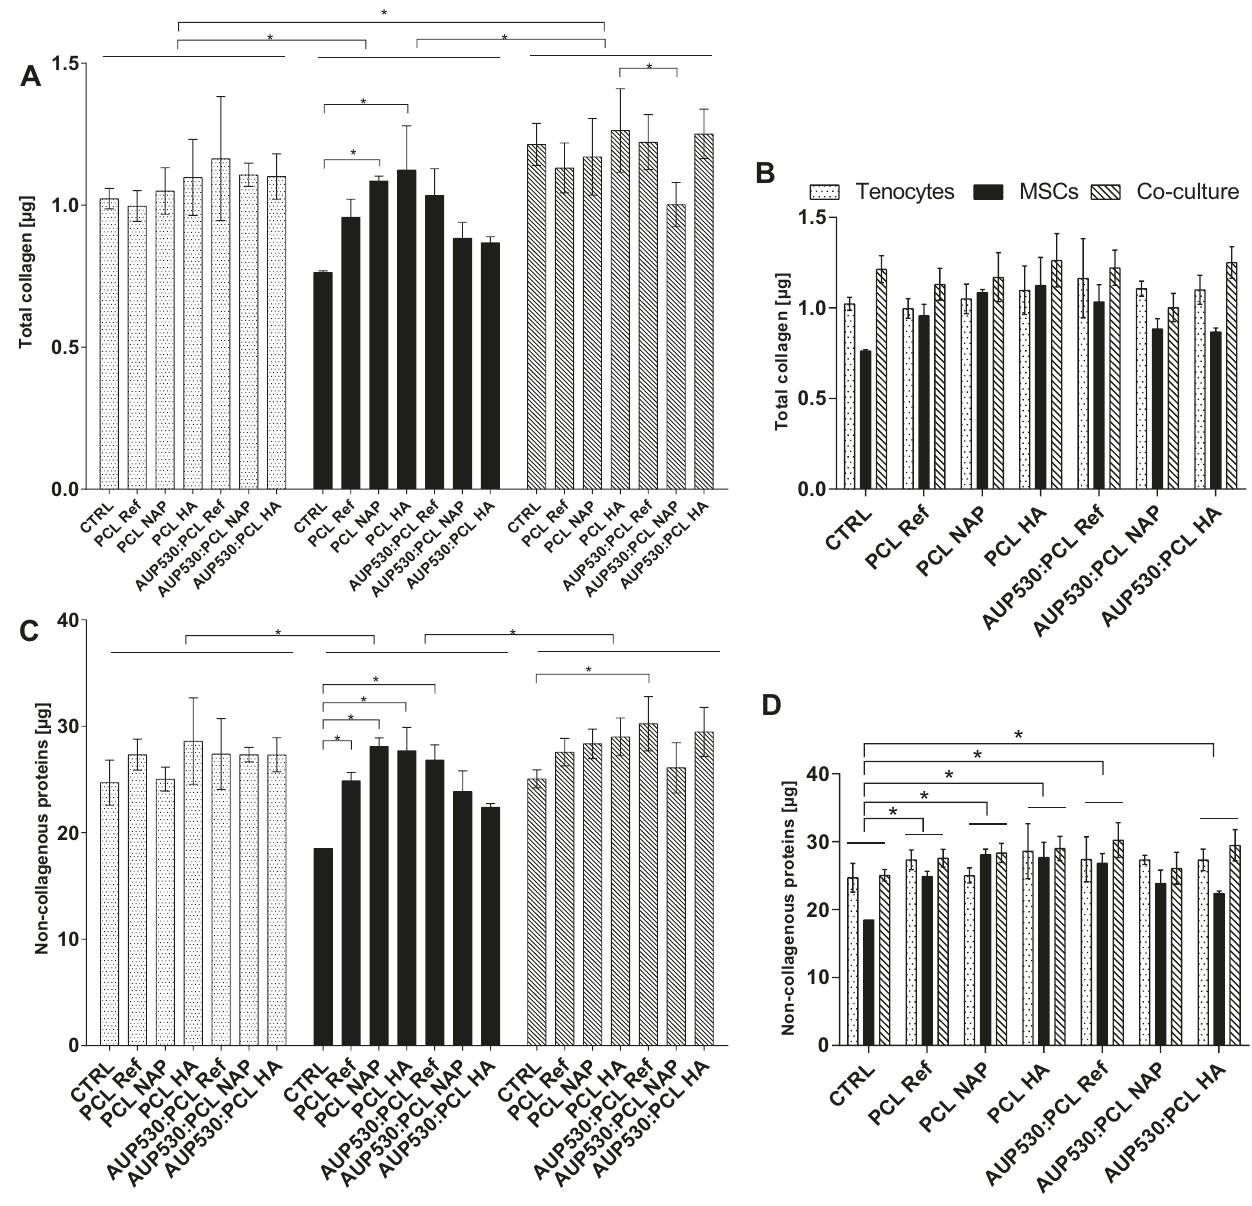
Fig. 8 Production of total collagen ( A , B ) and non-collagenous pro- teins ( C , D ) illustrated in mono-cultures (tenocytes or mesenchymal stem cells, MSCs) and co-culture (tenocytes & MSCs) after an incu- bation of 7 days, including overall effects ( B , D ). Cells were cultured